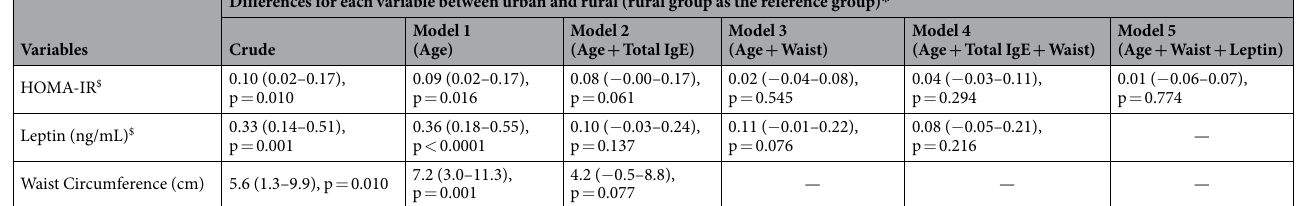
Table 2. Associations between living in urban and rural area with HOMA-IR, leptin, and waist circumference. * Beta coefficient (95% CI) from linear regression. $ HOMA-IR and leptin level were log transformed for analysis. Model 1: adjusted for age. Model 2: adjusted for model 1 plus total IgE level. Model 3: adjusted for model 1 plus waist circumference. Model 4: adjusted for model 2 plus waist circumference. Model 5: adjusted for model 3